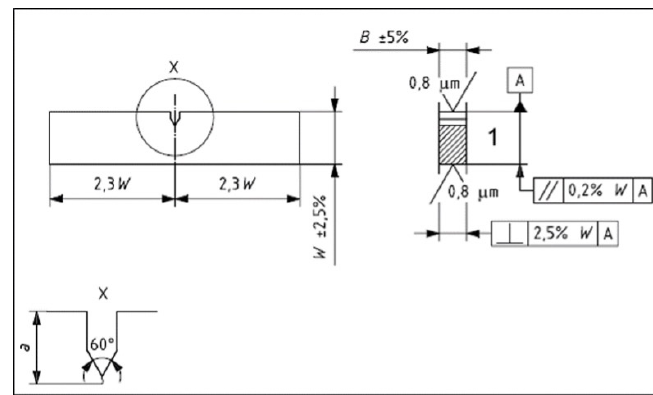
Figure 5. Dimension and tolerances of CTOD specimen, test 12 .